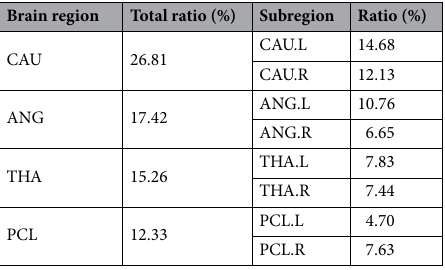
Table 5. Brain regions most contributive to classification. CAU caudate nucleus, ANG angular gyrus, THA thalamus gyrus, PCL paracentral lobule, L left, R right.